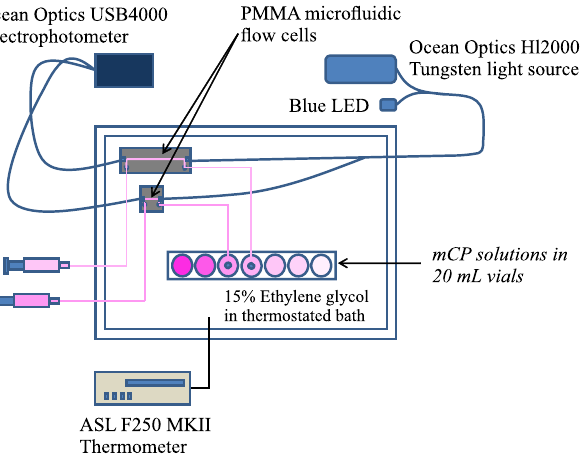
Figure 1. Experimental setup used for the determination of the molar absorptivity ratios e 1 and e 3 /e 2 . The microfluidic flow cells and vials with m CP solutions are submerged in a 15% ethylene glycol thermostated bath. The light is transmitted from the light source to the flow cells and to the spectrophotometer through 600 µ m diameter optical fibres (Thorlabs, USA).